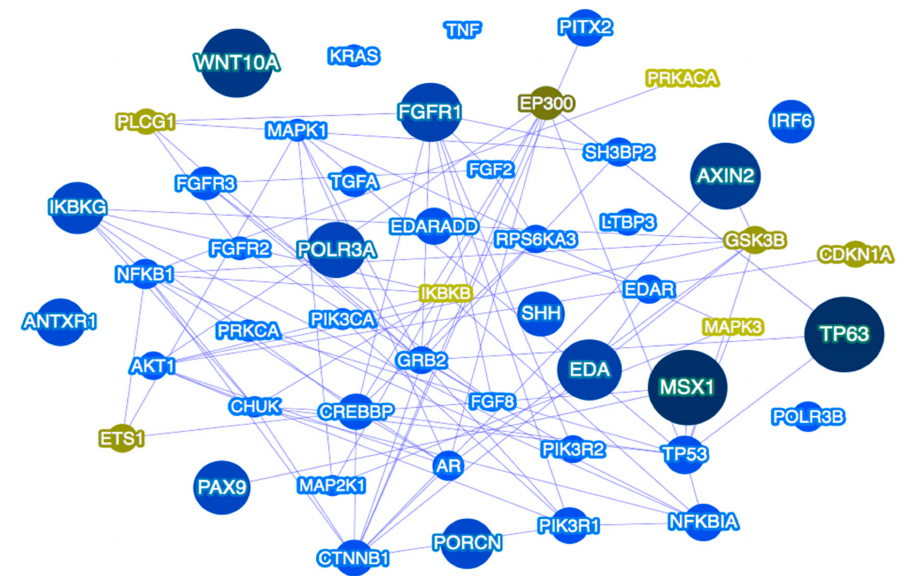
Figure 2. Tooth agenesis gene network as predicted by Phenolyzer [183]. The network shown includes the top 50 prioritized genes, and their predicted relations with seed genes. Larger dark blue nodes indicate seed genes, medium royal blue nodes indicate interacting genes. Green font indicates predicted genes. Blue lines indicate protein–protein